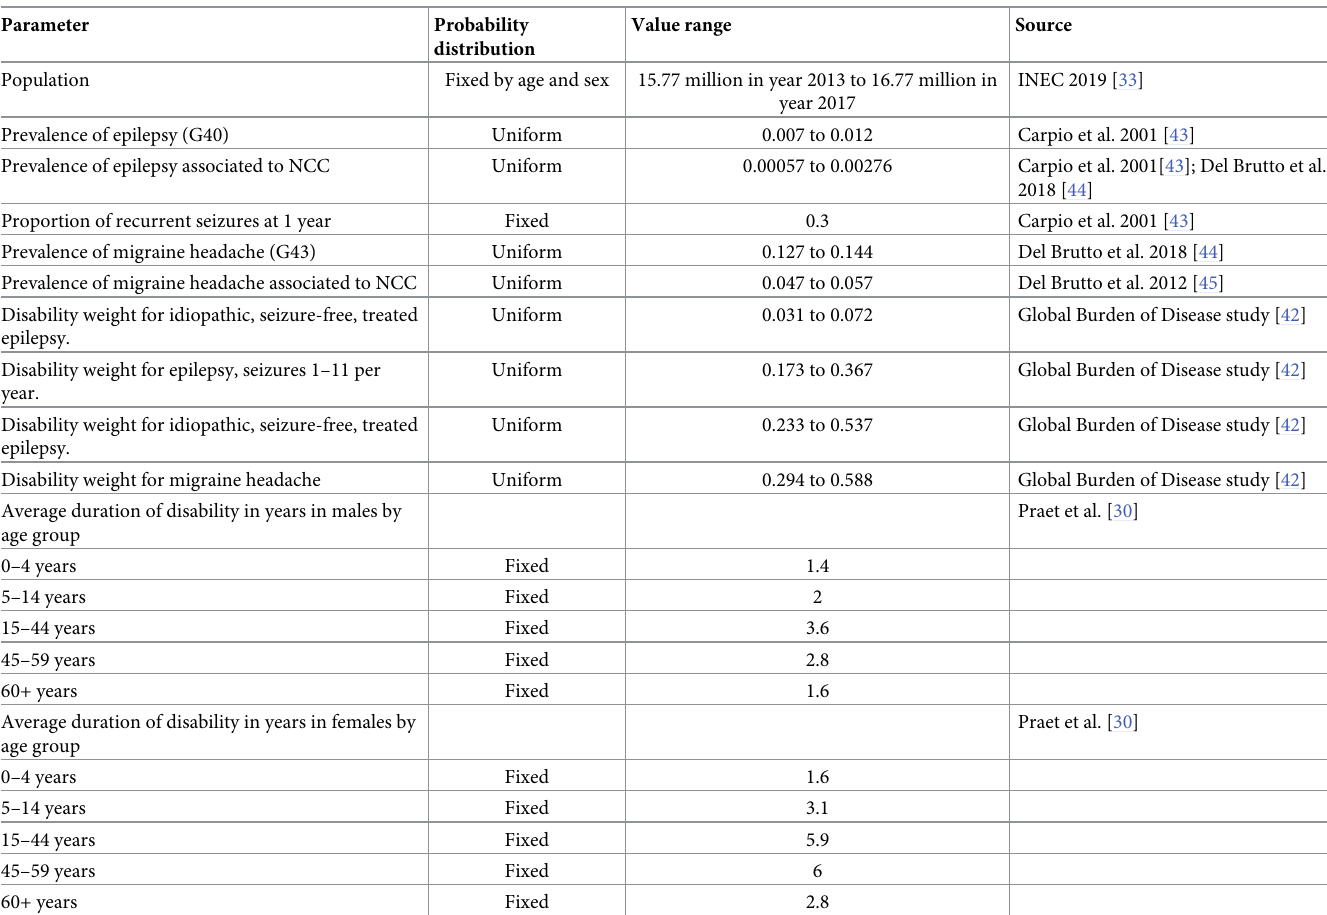
Table 1. Parameters used for the burden estimation of NCC in the DALY calculator for